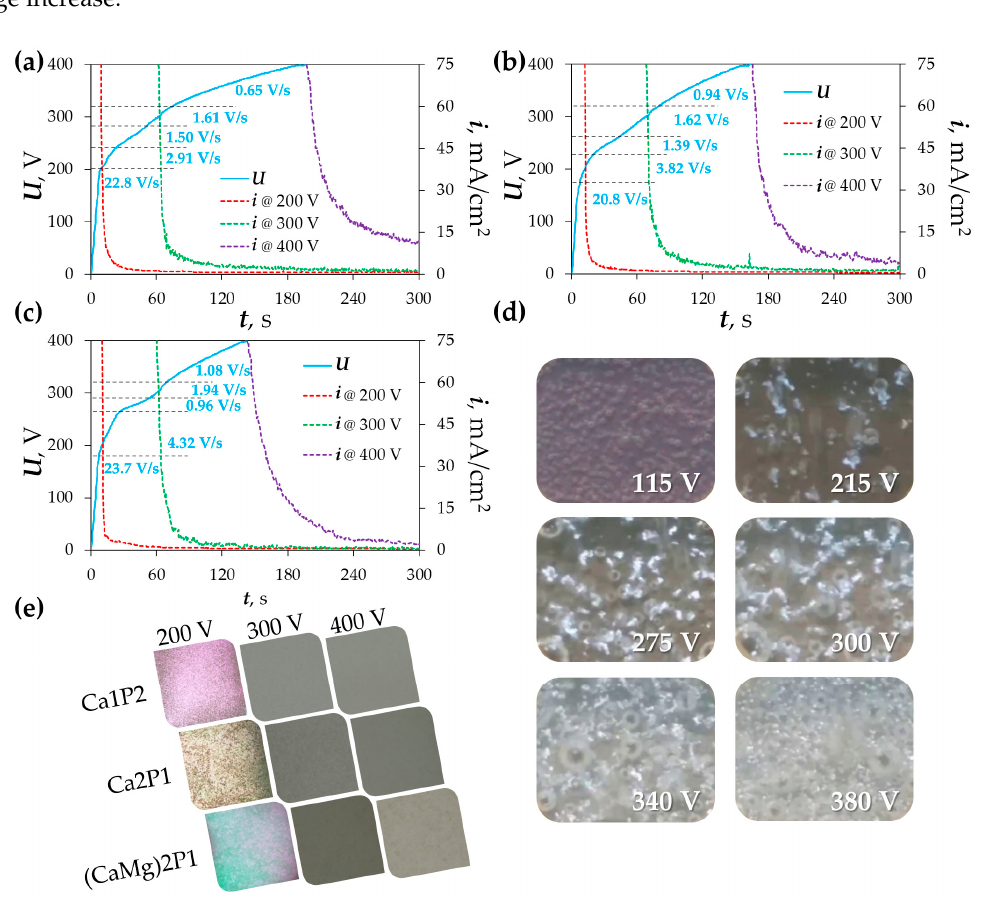
Figure 2. Voltage ( U ) and current density ( i ) transients recorded during the galvanostatic